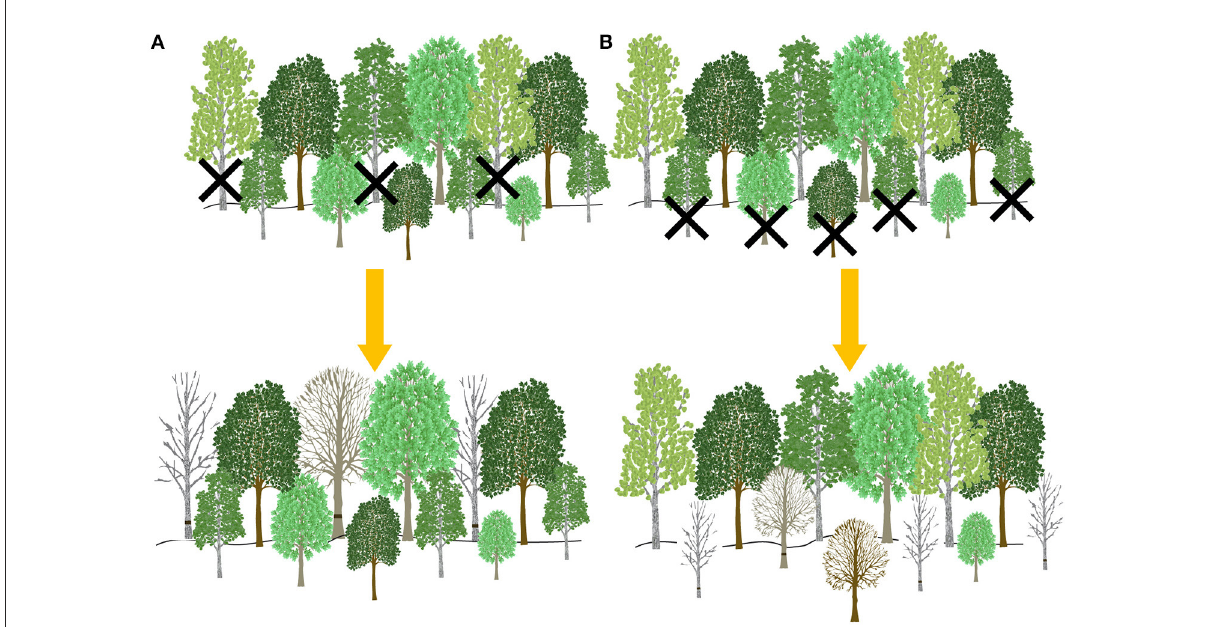
FIGURE2 A representation of the two treatment types used in each subplot. In the top-down treatment type, the largest upper canopy trees ( > 8cm) were girdled until the designated disturbance severity target (either 0, 45, 65, or 85% gross defoliation) was reached (A) . In the bottom-up treatment type, the smallest upper canopy trees ( > 8cm) were girdled until the designated disturbance severity target was reached (B) . The bottom half of the figure illustrates the predicted remnant forest structure 3 years after disturbance